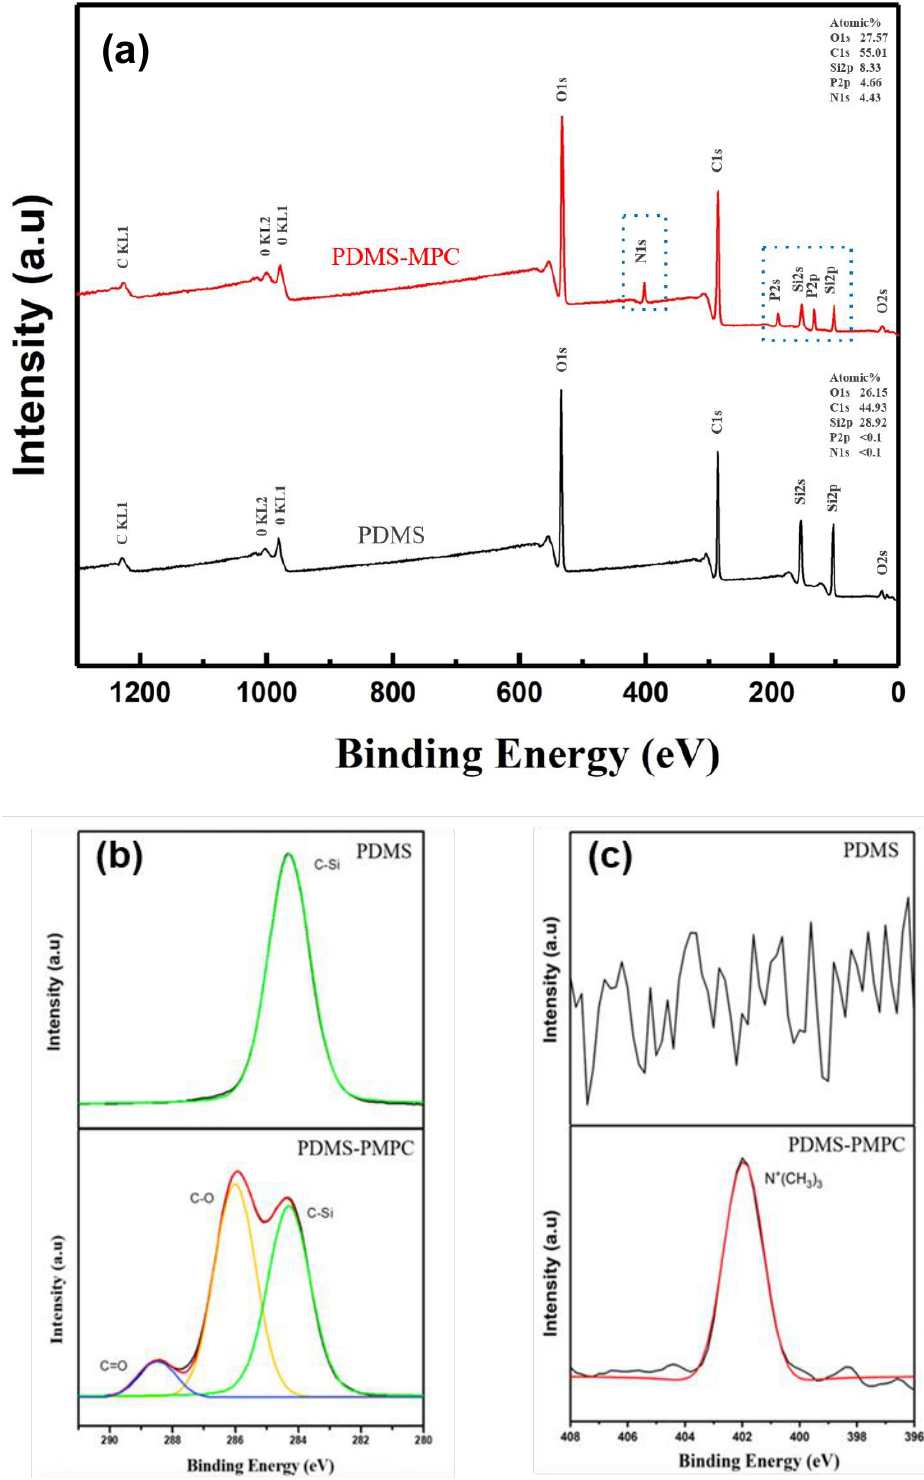
Figure 9. ( a ) XPS full spectra, ( b ) C-1s spectra, and ( c ) N-1s spectra of the PDMS and PDMS-PMPC substrates.